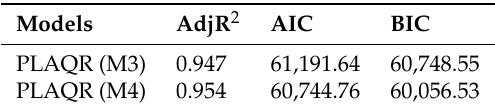
Table 4. Model selection for partially linear additive quantile regression model (PLAQR) with and without